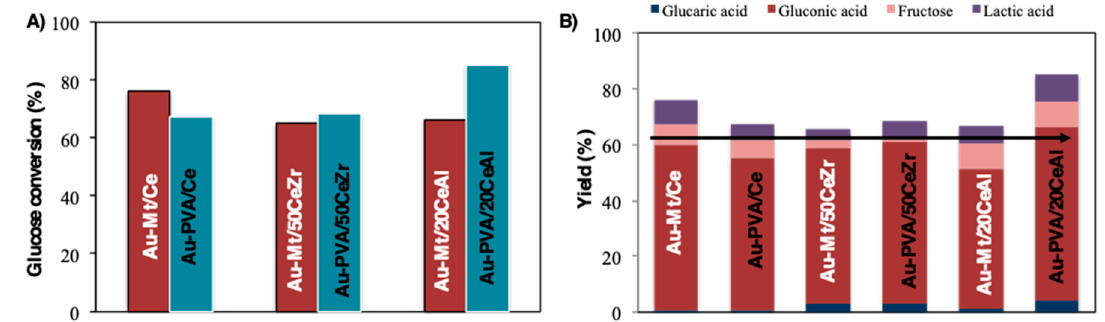
Figure 5. Glucose conversion ( A ) and product yields ( B ) as a function of support.